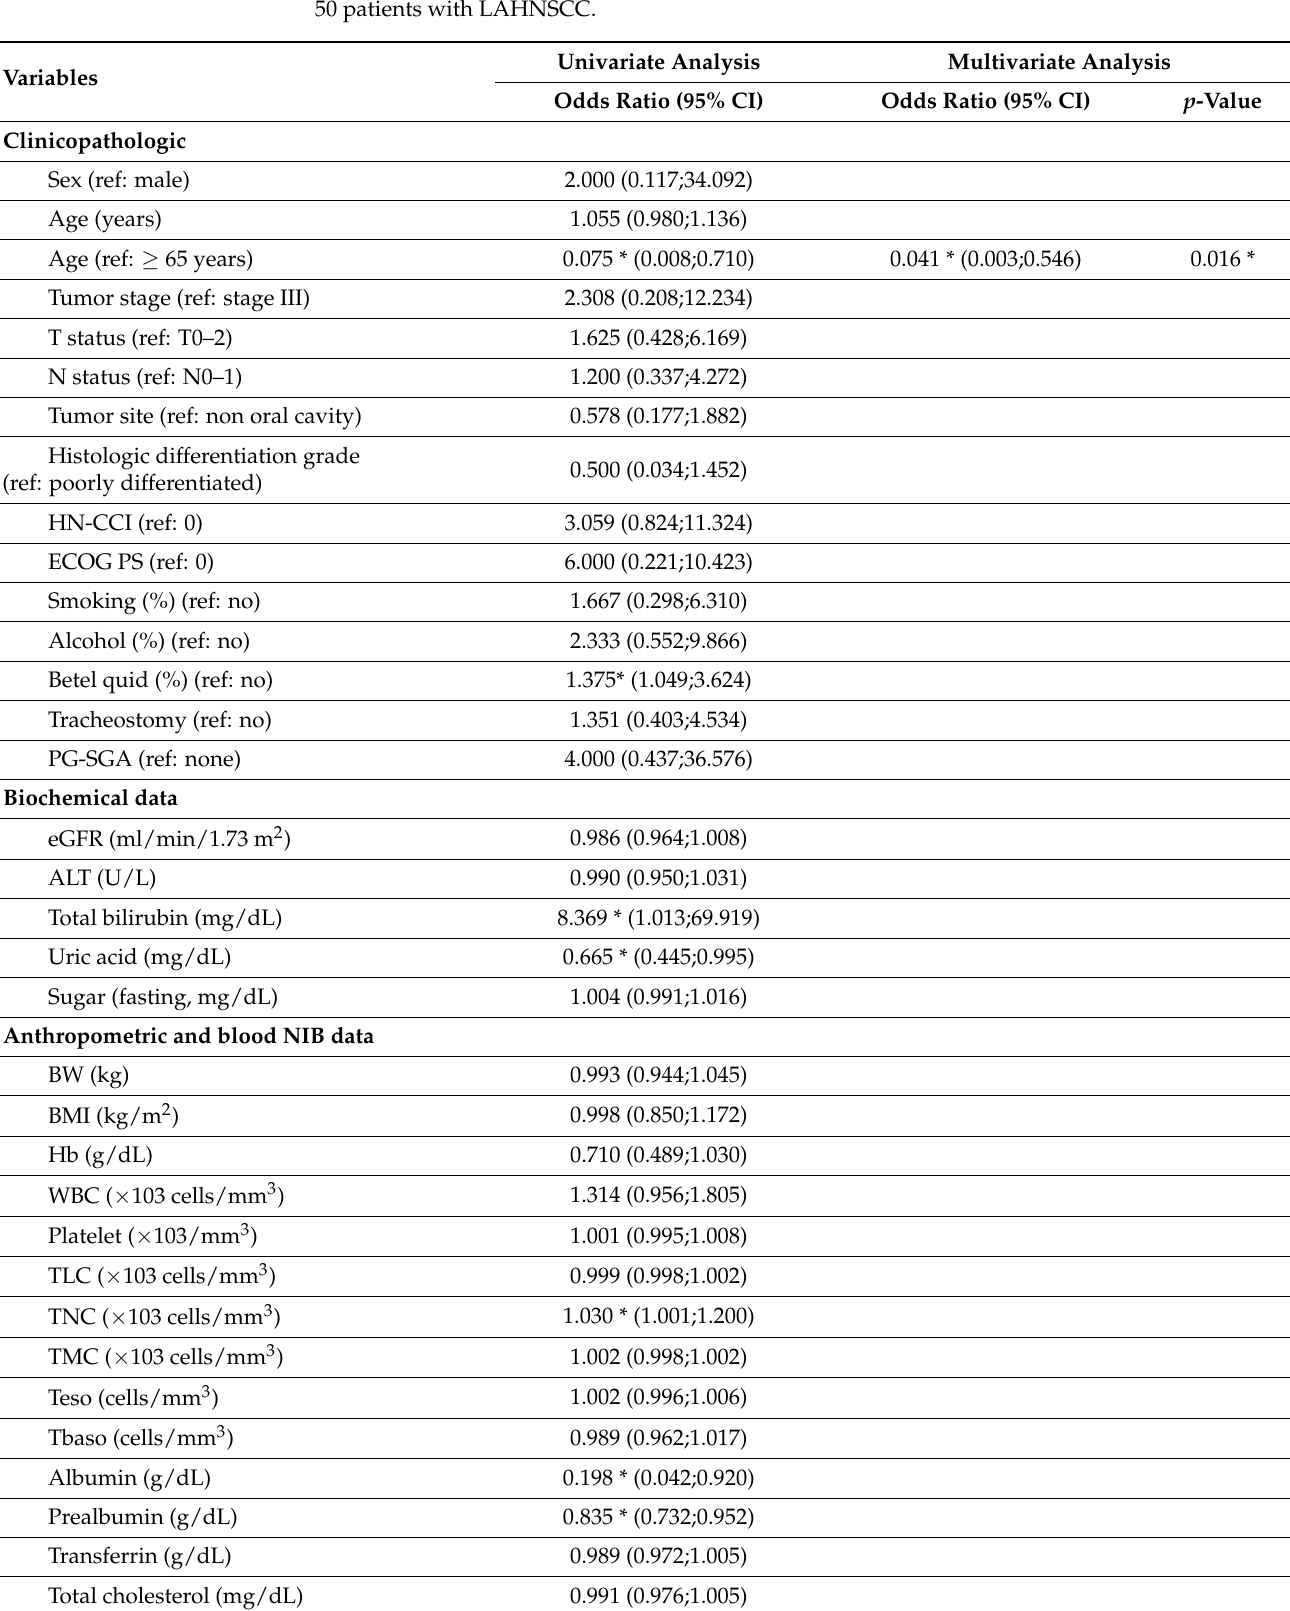
Table 4. Univariate and multivariate logistic regression analysis of factors associated with GPS ≥ 1 in 50 patients with